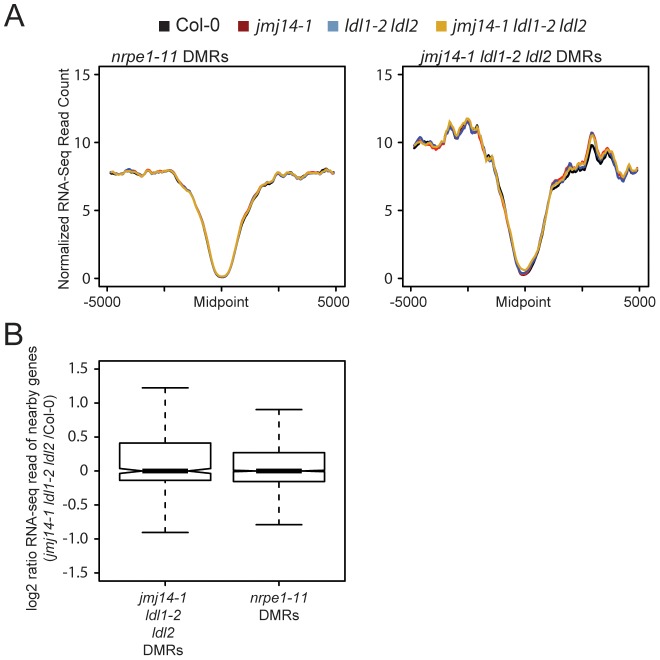
Changes in histone methylation at DMRs do not correlate with alterations in mRNA expression.(A) Metaplot of normalized RNA-seq read counts over nrpe1-11 and jmj14-1 ldl1-2 ldl2 DMRs. (B) log2 ratio of gene expression for genes with promoters overlapping with different DMRs.